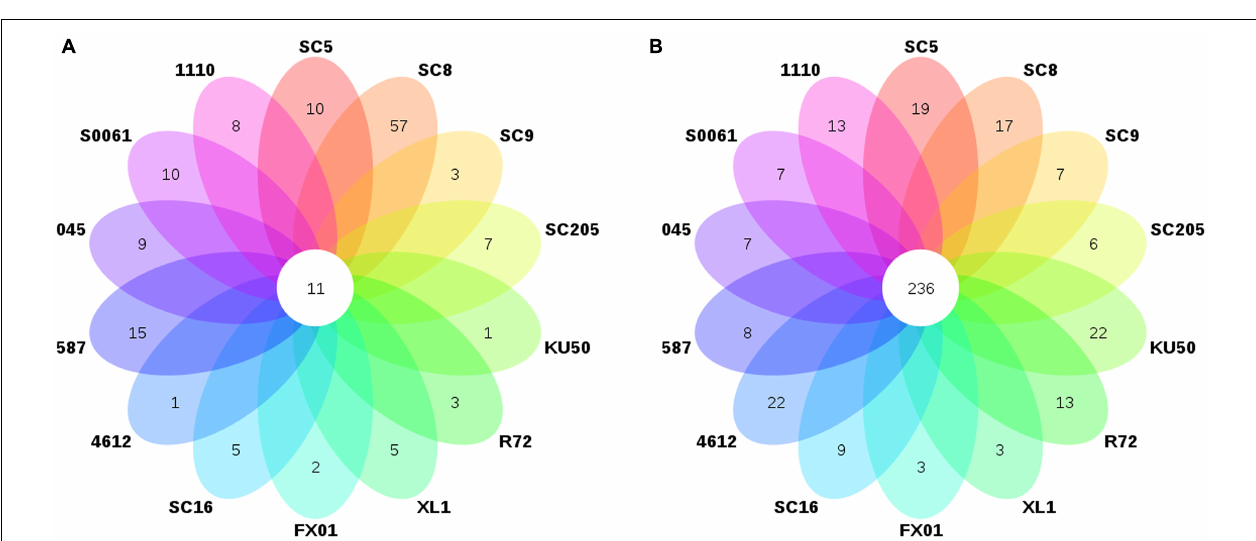
FIGURE 3 | Number of bacterial genera in (A) the tuberous roots and (B) the rhizosphere soil of different cassava